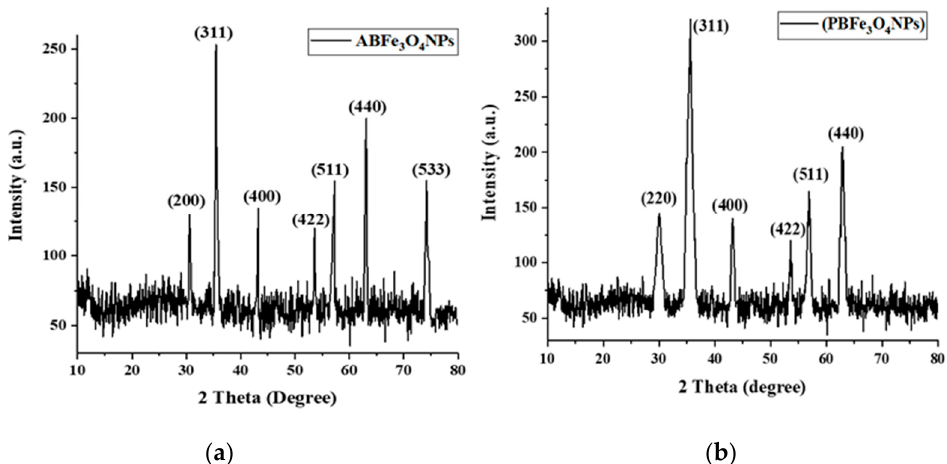
Figure 3. ( a ) XRD pa tt ern of algal-based Fe 3 O 4 NPs ( b ) XRD pa tt ern of plant-based Fe 3 O 4 NPs.